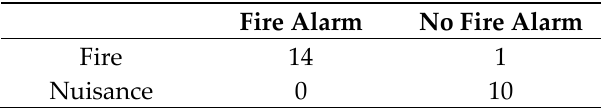
Table 2. Confusion matrix of the model when it is trained with data from standard fire room and data acquired at smaller-scale setup. Additional measurements help to adjust alarm levels so none of the nuisances generates a false